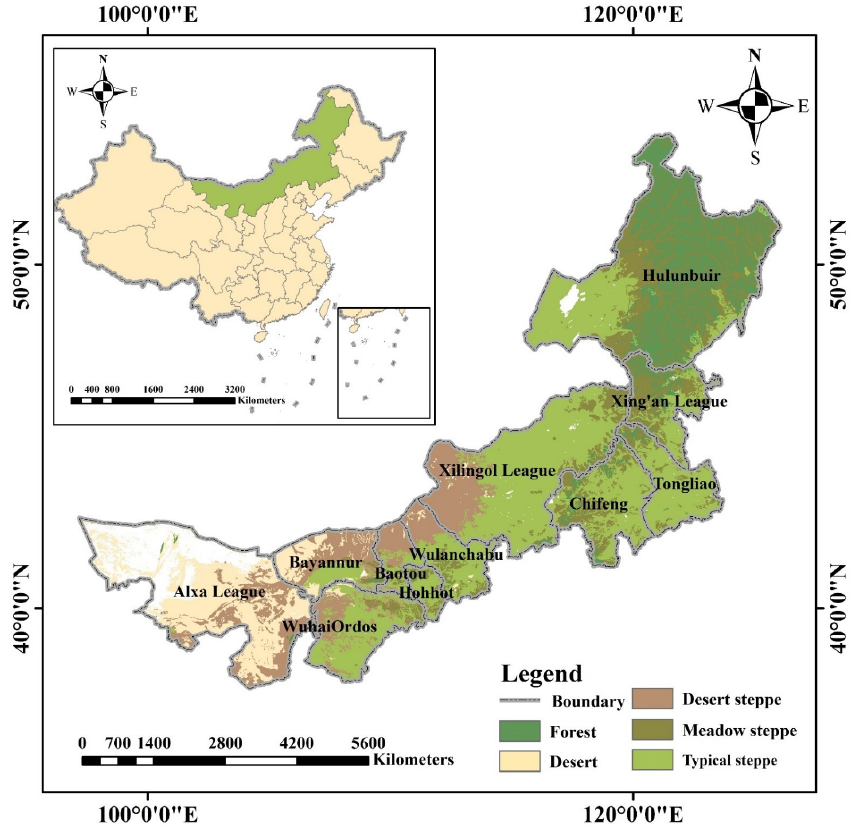
Figure 1. Study area, and the different vegetation and steppe types in Inner Mongolia.